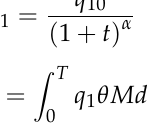
Figure 5. Correlation analysis between gas concentration and input data: ( a ) Scatter plot of correlation between mixed methane concentration and ambient temperature; ( b ) Scatter plot of correlation between mixed methane concentration and back air methane concentration; ( c ) Scatter plot of correlation between the concentration of mixed methane and the instantaneous flow of pipeline; ( d ) Scatter plot of correlation between mixed methane concentration and working velocity and back air.